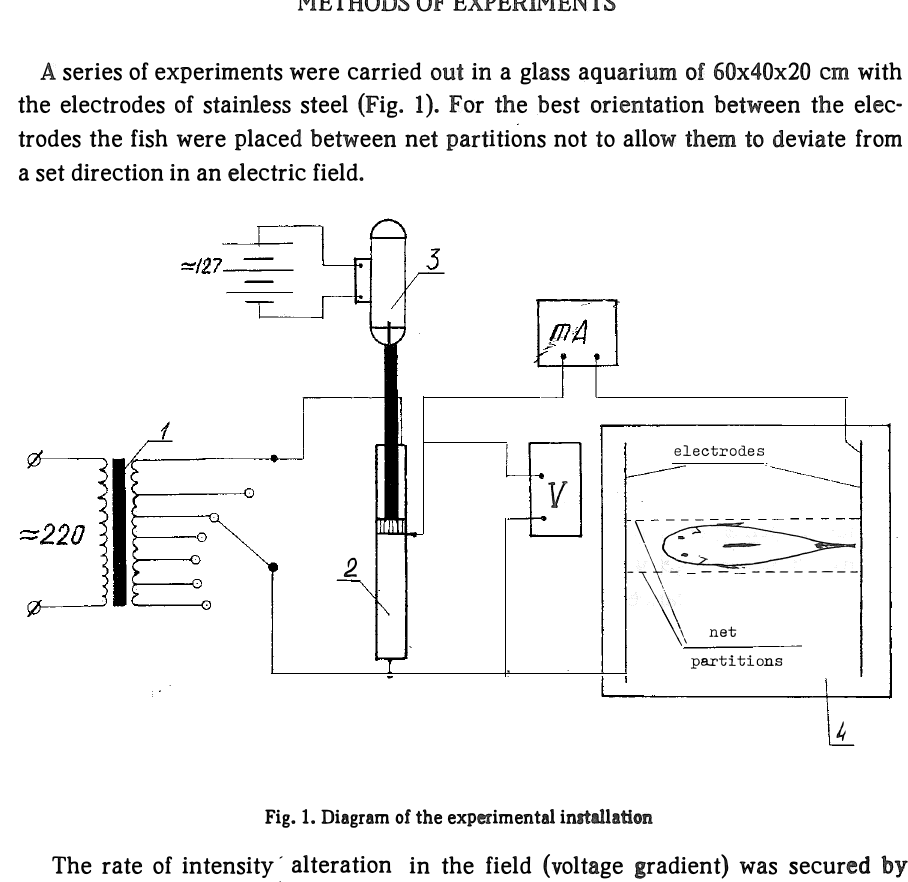
Fig. 1. Diagram of the experimental